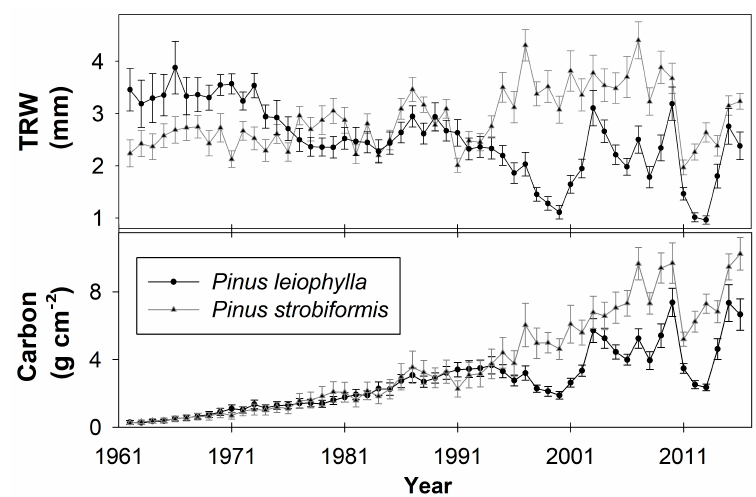
Figure 2. Average trends and standard error (mean ± SE) of the variables annual ring width (TRW)